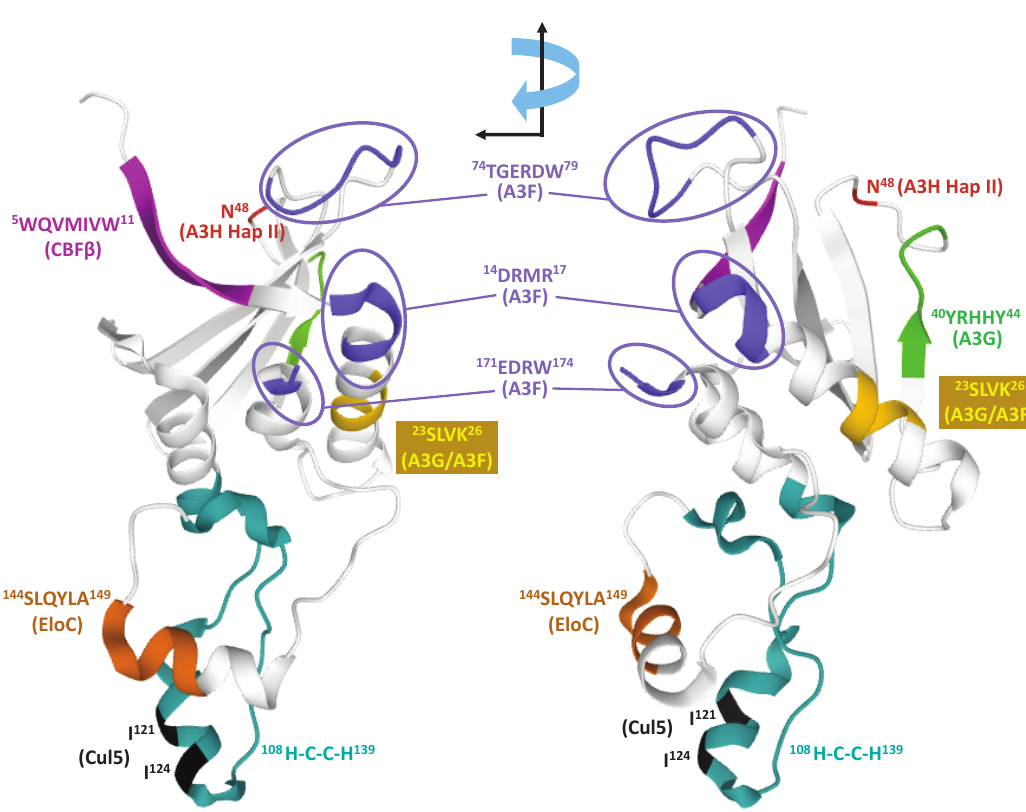
Figure 4. Domains of Vif involved in interactions with A3 proteins and CRL5 E3 ubiquitin ligase. Only the structure of Vif, in complex with CBF β , Cul5, and EloB / C, is shown (PDB: 4N9F). Residues involved in interactions with A3 proteins are shown using Rasmol software (www.rasmol.org). Residues involved in interaction with A3F, A3G, and A3H hap II are shown in purple, green, and red, respectively. Residues that are involved in interaction with both A3G and A3F are shown in gold. Residues involved in interactions with CBF β , EloC, and Cul5 are shown in magenta, brown, and black,